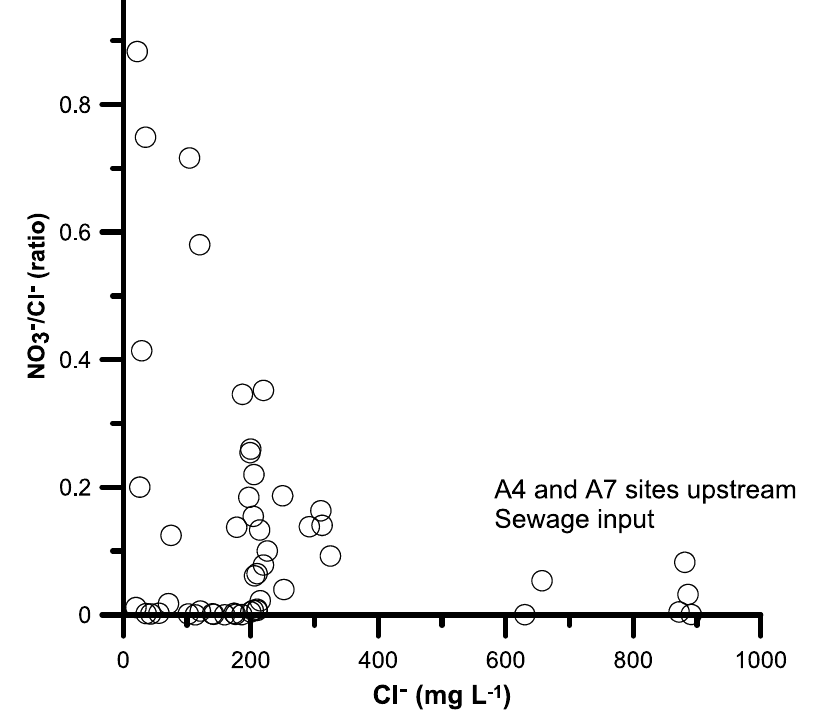
Figure 6. Chloride nitrate ‐ nitrogen ratio in stream waters from the Chaminé stream.